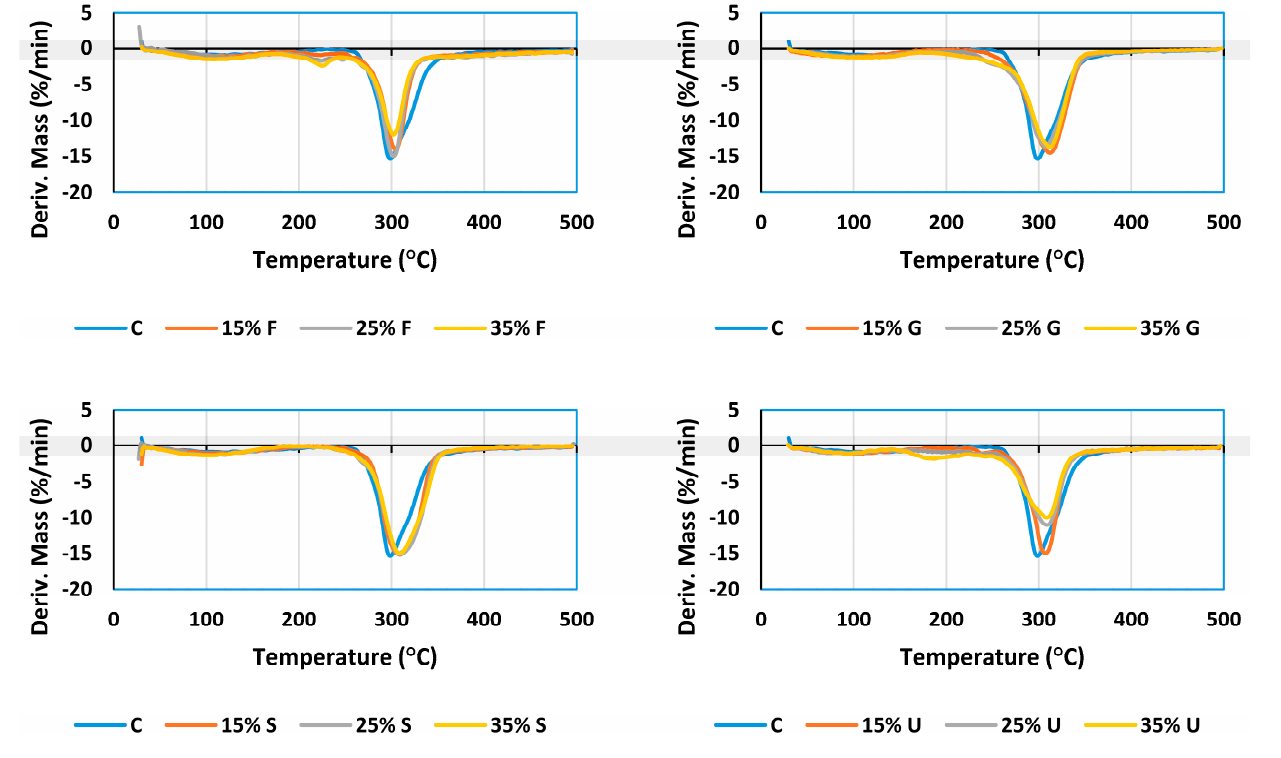
Figure 8. DTG curve of wheat starch plasticized films with various plasticizer types and concentra- tions.